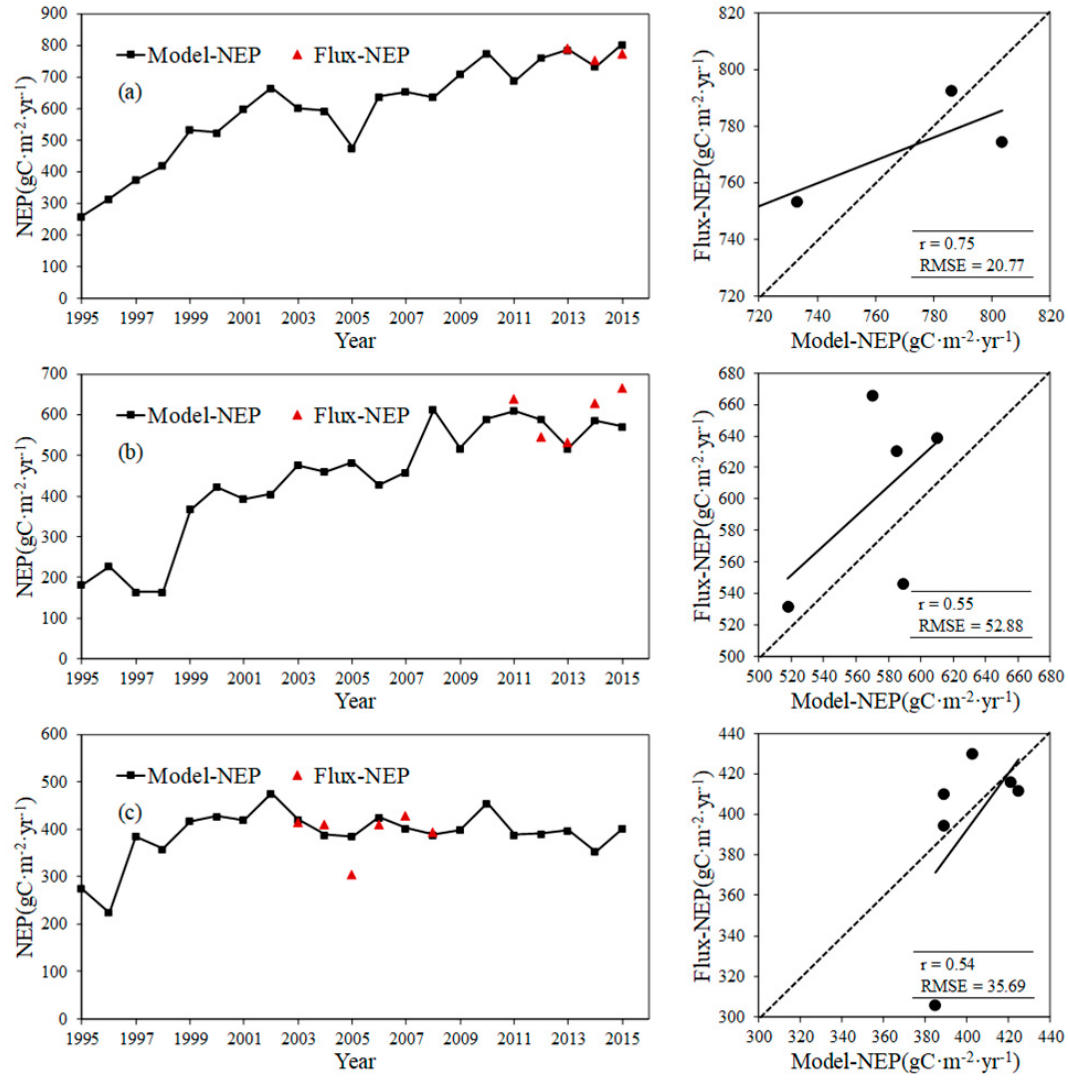
Figure 5. Comparison between the model simulation net ecosystem productivity (NEP) and flux NEP at ( a ) the Tianmushan flux site, ( b ) the Anji flux site and ( c ) the Qianyanzhou flux site.